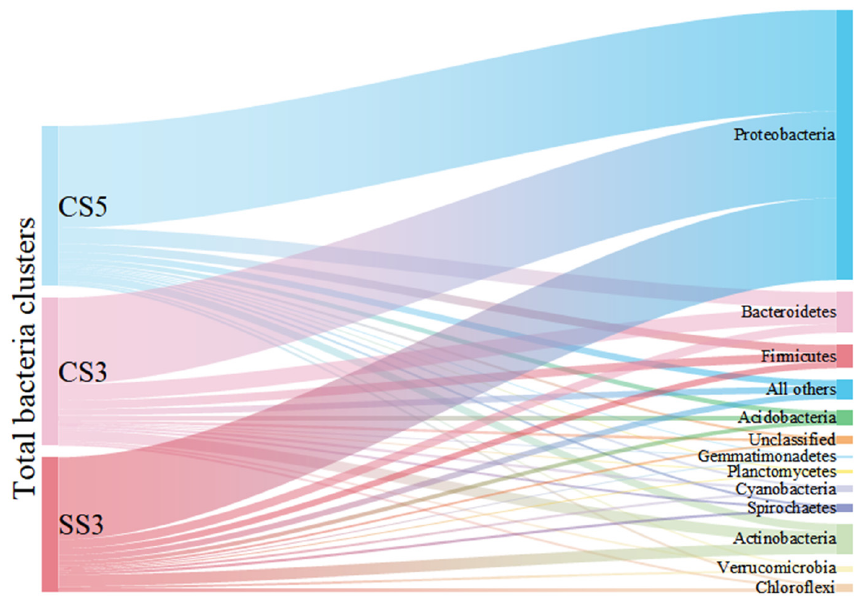
Figure 2. Sankey diagram of taxonomic breakdown (at the phylum level) of three MBRs.